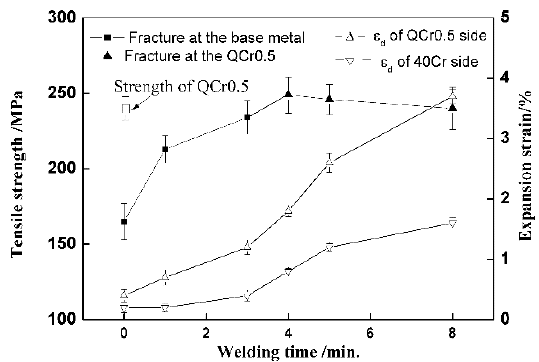
Figure 11. Curves of tensile strength and expansion strain vs. welding time. ( E = 3 kV/cm, T = 740 °C, P 0 = 56.6 MPa, ε 0 = 1.5 × 10 − 4 s − 1 ).